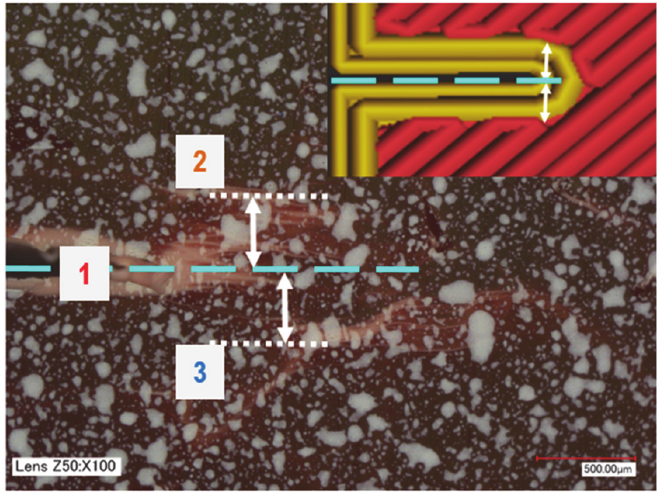
Figure C1: Illustration of the position of zones (2) and (3) in regard of the crack tip (zone (1))